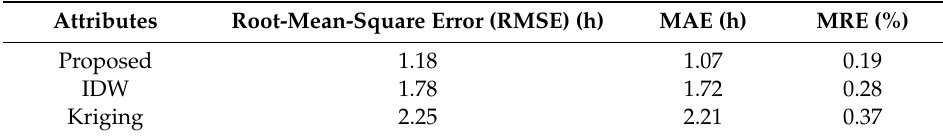
Table 3. Summary of model evaluation using Inverse distance weighting (IDW) and kriging.